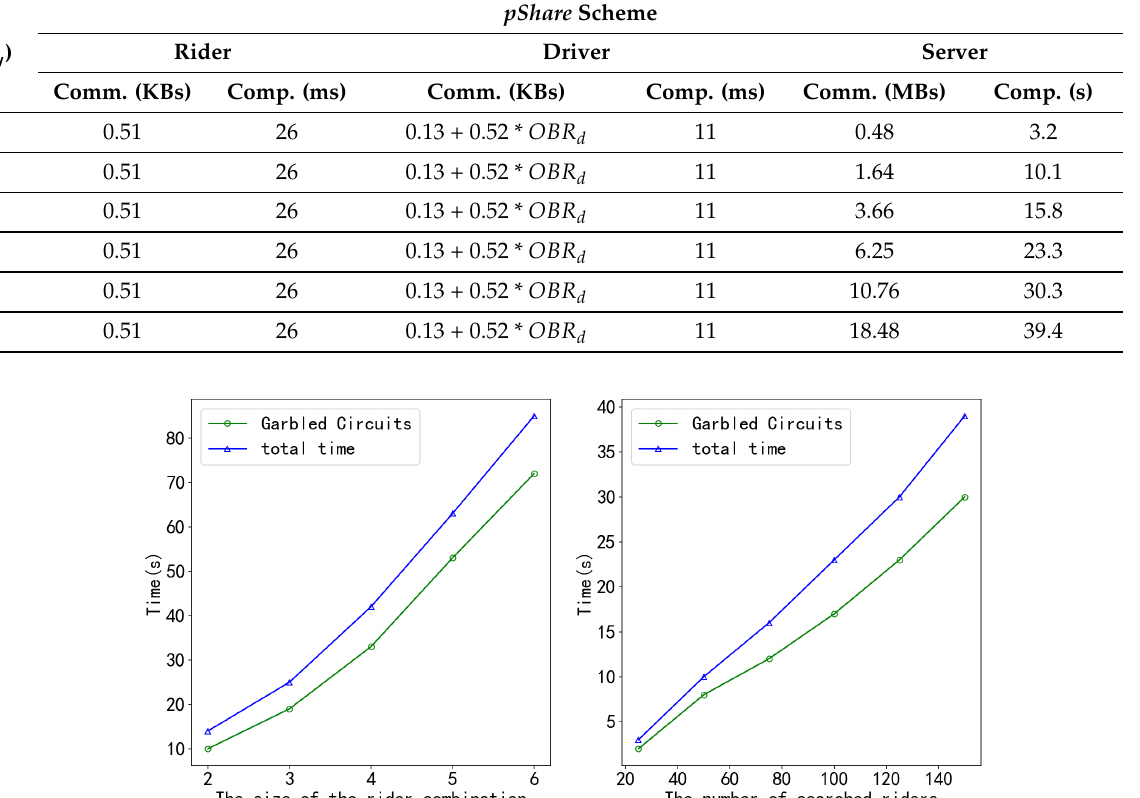
Figure 8. Per matching computation cost of servers under different size of rider combination and number of searched